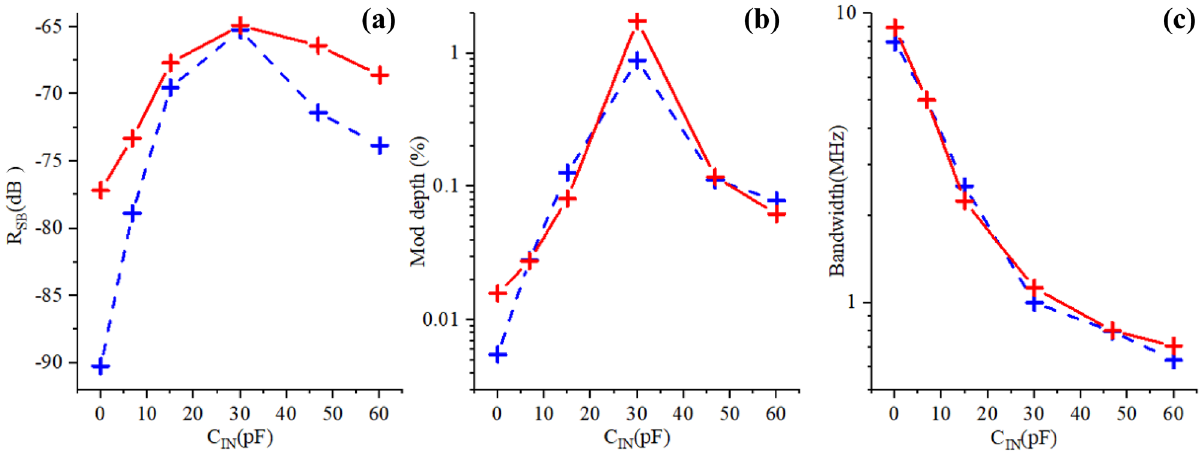
Figure 10. Three important parameters plotted vs balancing capacitor C IN . Red crosses with solid lines— simulation, blue crosses with dased lines-experiment. Left: SB magnitude normalized to C IN Middle: Modulation depth, in percent; ˜ V g is 65 mV peak for all C IN , except for C IN (on -3 dB level) f Mod available for SEBA sensing. Note that here the experimental data are not subjected to calibration/error